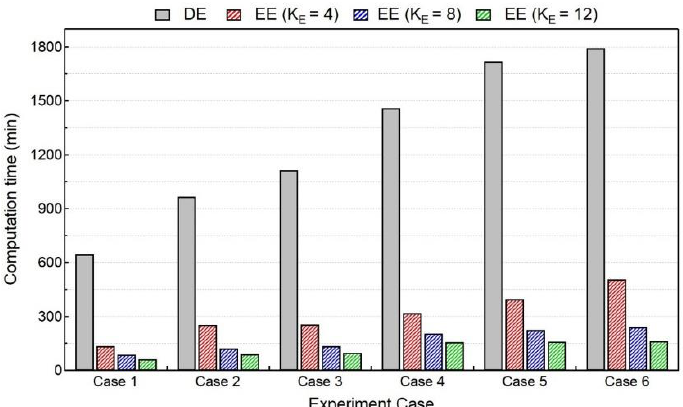
Figure 13. Comparison of computation time for mechanical analysis between DE and EE heat sources with different elongated length.